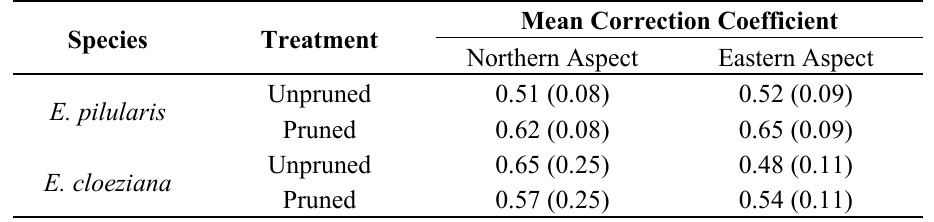
Table 2. Sap velocity correction coefficients by species and treatment. Values in parentheses refer to standard errors of mean. There were no significant differences ( P > 0.05) in coefficients within species either between treatments or